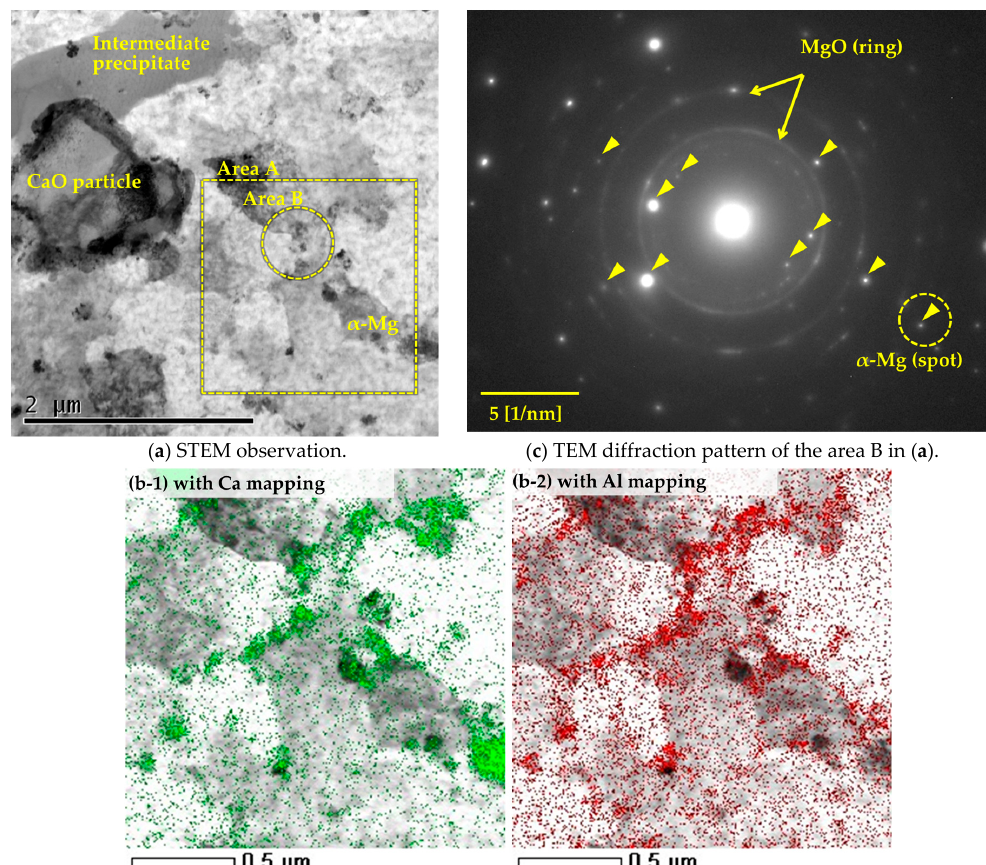
( b ) Superposition of TEM observation on the area A in ( a ) with EDS mapping analysis; Ca ( b-1 ) and Al ( b-2 ). Figure 6. Transmission electron microscopy (TEM) observation result of the Mg-Al-CaO precursor with 10-vol % CaO particles after the heat treatment at 500 °C for 300 s. STEM: scanning transmission electron microscopy; EDS: energy-dispersive spectroscopy.